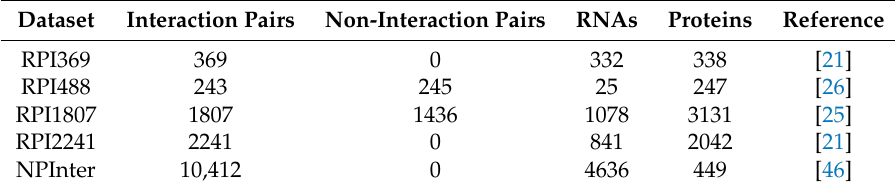
Table 4. The five benchmark RPI datasets used in this